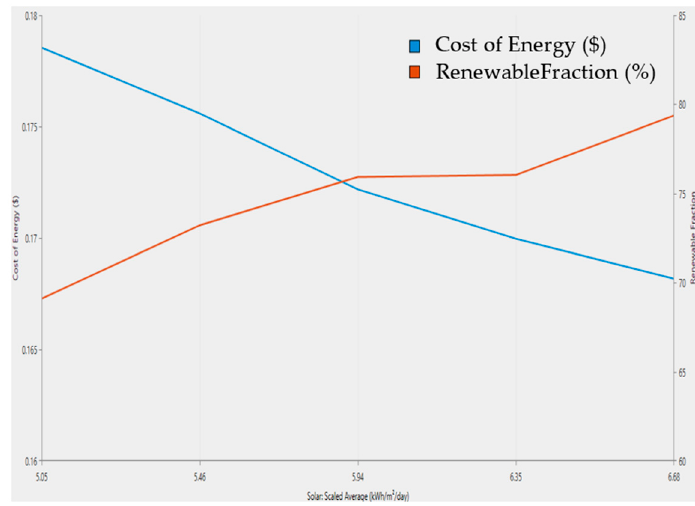
Figure 16. LCOE and RF related to GHI variations.